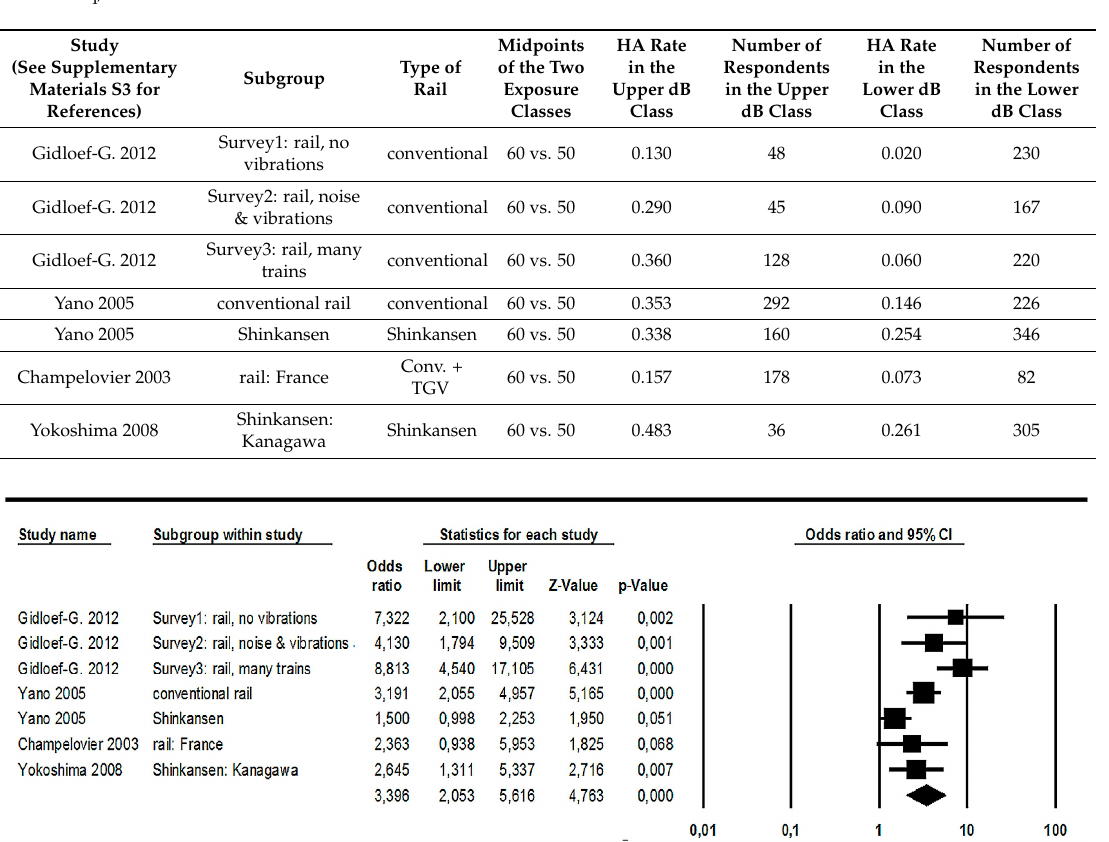
Table 6. Railway traffic noise—HA rates and the number of respondents in two classes of exposure ( L Aeq,24h ).